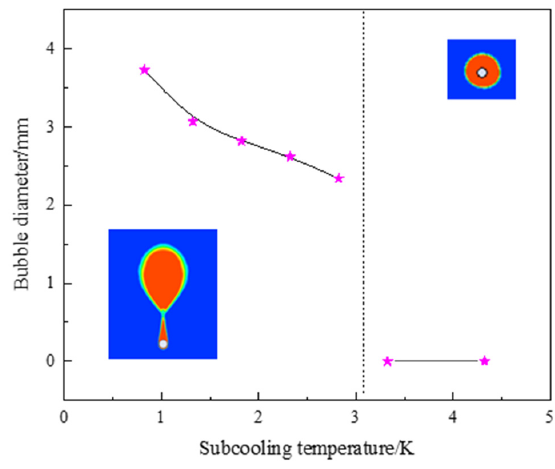
Figure 16. The thermal performance for the wire heating surface.